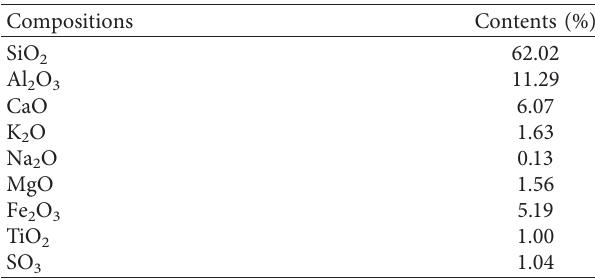
Table 2: Main chemical components of fly ash (%).